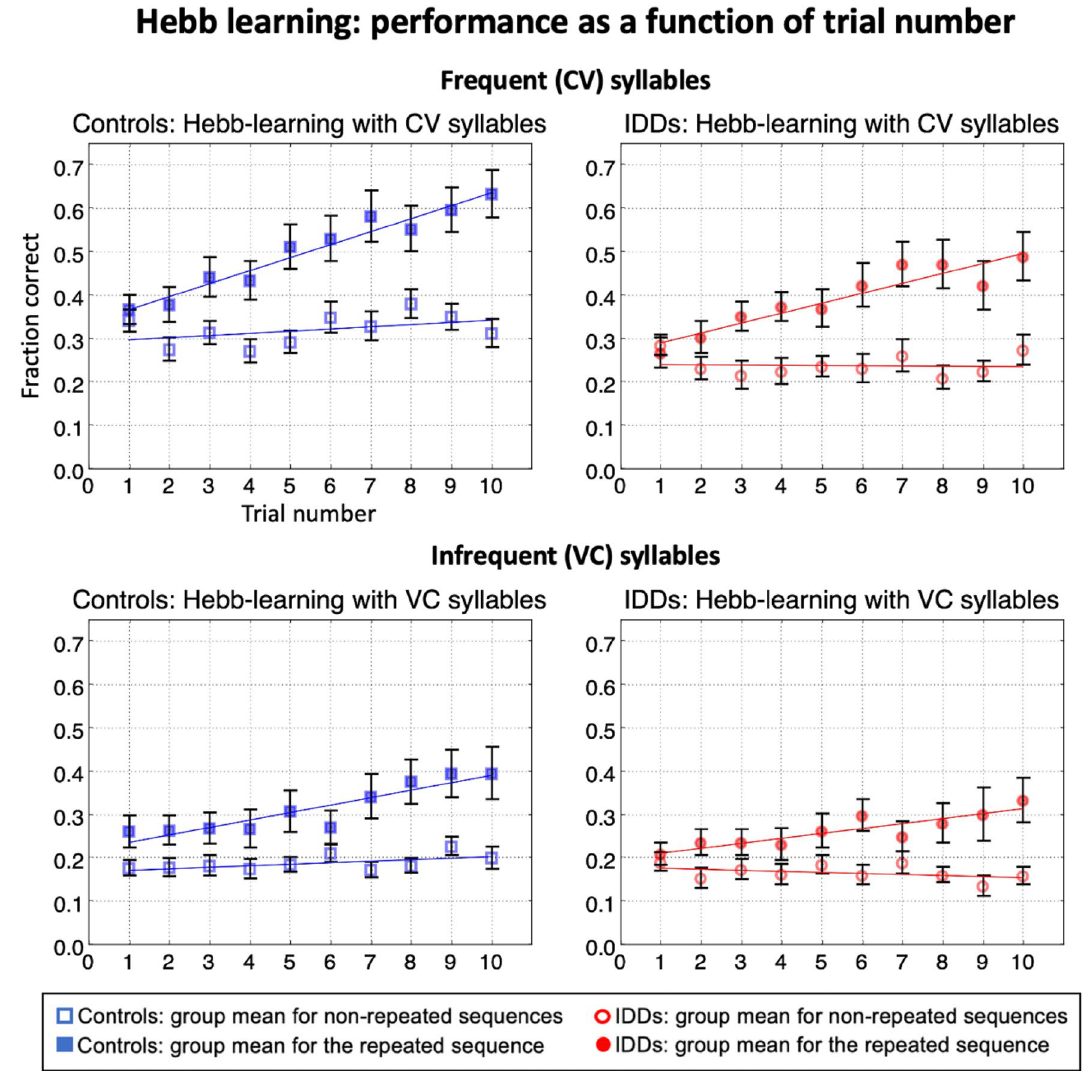
Figure 4. Fraction correct as a function of trial number for both repeated and non-repeated sequences of controls (left) and IDDs (right), for CV (top) and VC (bottom) syllables. Though controls’ CV scores for the non-repeated sequences are higher than IDDs’ (the regression line on the left has a higher intercept than the one on the right), the repetition-learning slopes do not differ between the groups. Error bars denote one